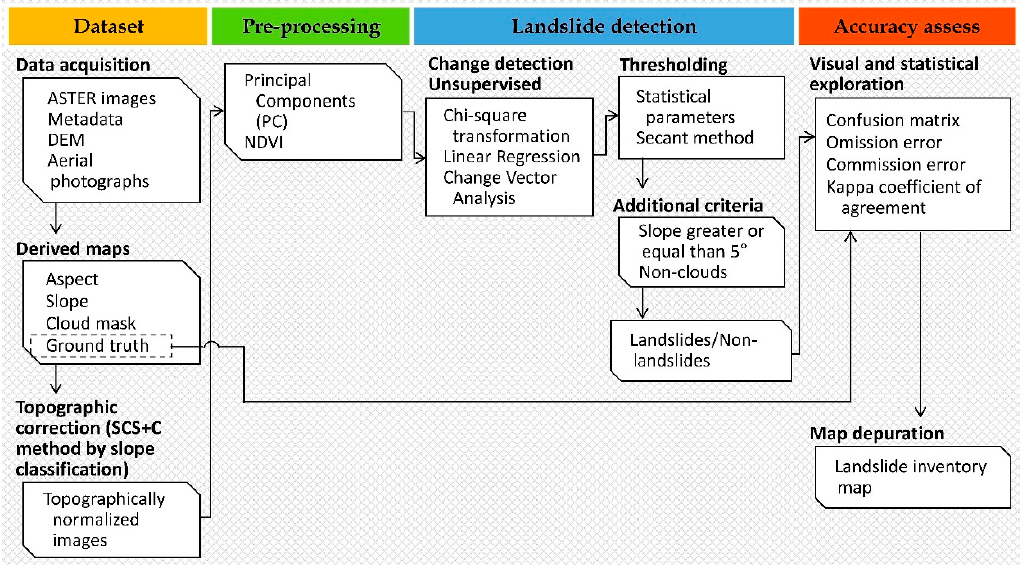
Figure 4. Methodology overview.